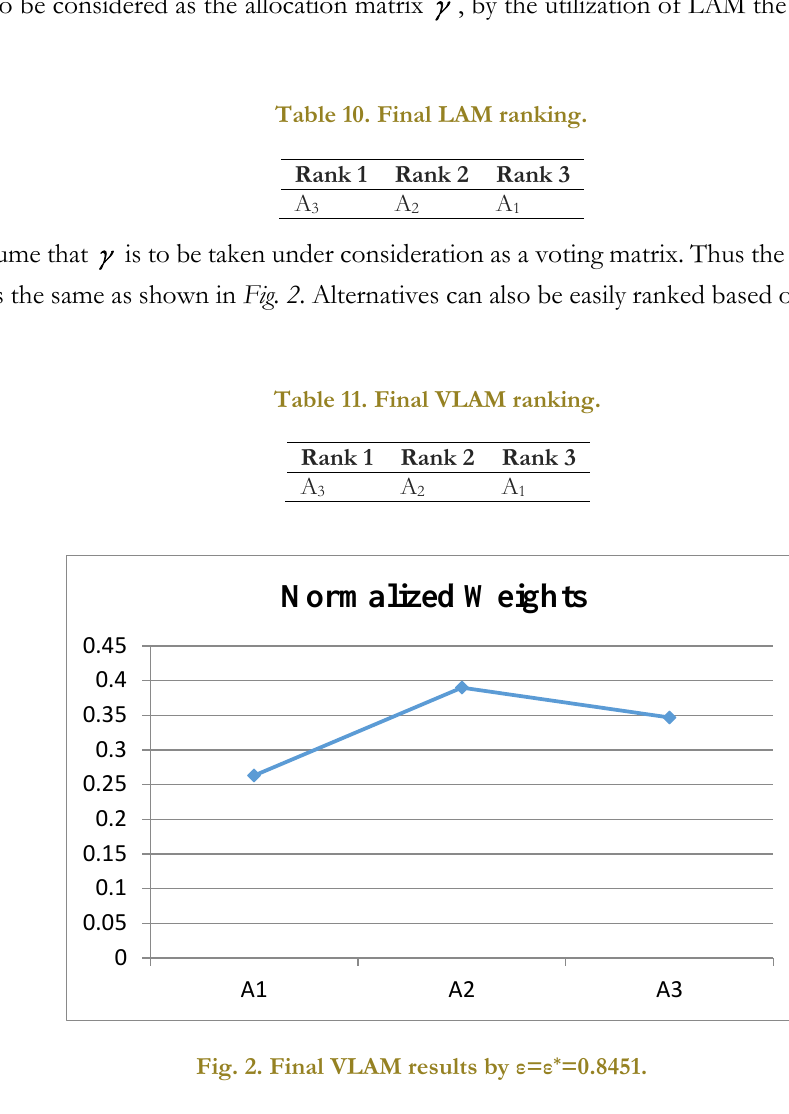
Table 10. Final LAM ranking.